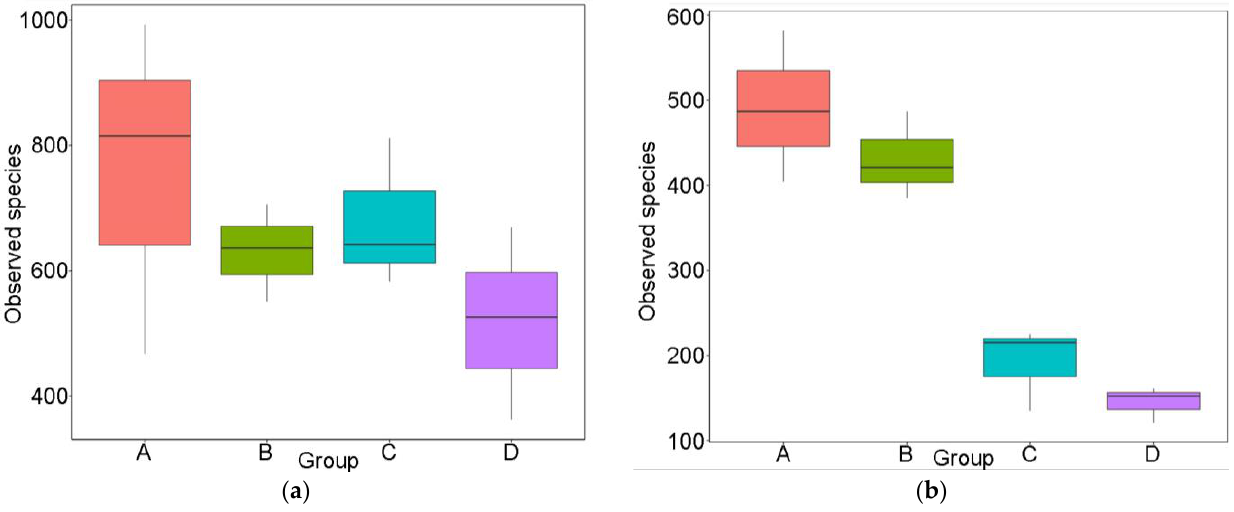
Figure 1. Observed unique operating taxonomic units (OTUs): ( a ) bacterial species and ( b ) fungal species in groups A, B, C and D.